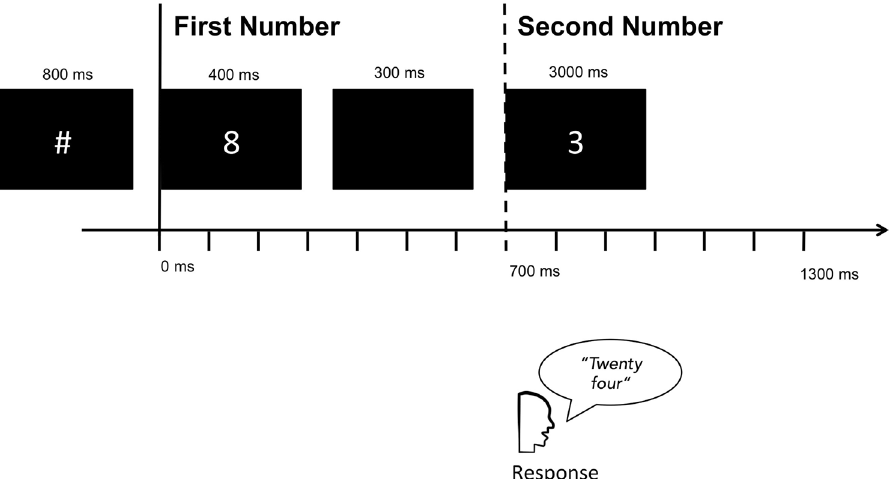
Figure 4. Schematic representation of the Task. The figure illustrates the task procedure. The participants were asked to answer after the Second Number , providing the results of the multiplication between the numbers. Analyses were conducted on source activity time-locked to the First Number (8 in the example, solid vertical line) and to the Second Number (3 in the example, dashed vertical line). The space between two ticks in the x-axis indicates a 100 ms interval. The figure was drawn by the first author of the paper—Giorgio